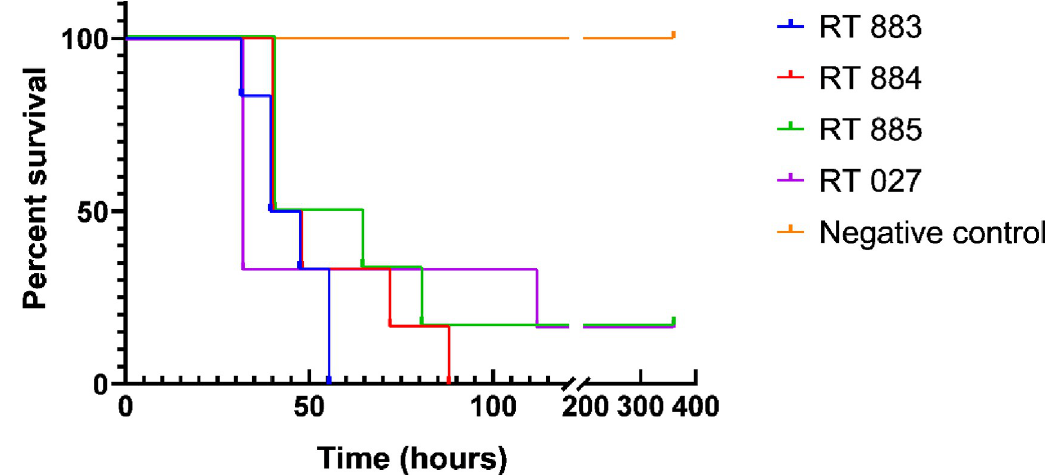
Fig 2. Kaplan-Meier survival curve of hamsters infected with 10 4 spores of RT883, RT884, RT885, reference control strain (CD196/RT027), and negative control. Syrian golden hamsters previously treated with clindamycin were orally inoculated with spores from the indicated strains. Hamsters were monitored at 8-h intervals for signs of Clostridioides difficile infection for 15 days, and the number of deceased animals was recorded.